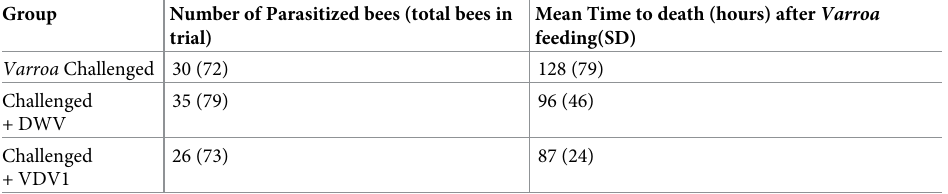
Table 4. Mean time to death after a Varroa feeding. Mean time (hours) to death reported for bees within each chal- lenged group for the whole trial, followed by count data of the number of bees parasitized in the trial. Analysis is pro- vided in the final column of the percentage of parasitized to non-parasitized bees per cage within each group ( ± SD). Group Number of Parasitized bees (total bees in